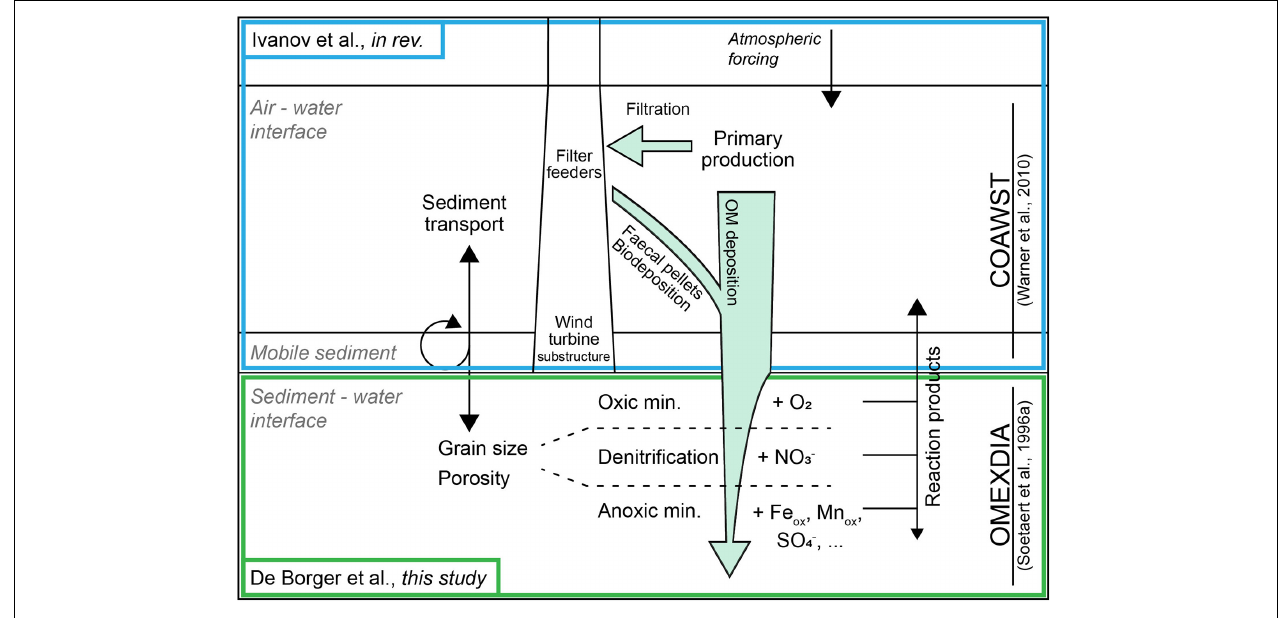
FIGURE 2 | Schema of the coupling of the COAWST hydrodynamic sediment transport model to OMEXDIA. increasing thickness, starting from 0.01 cm at the